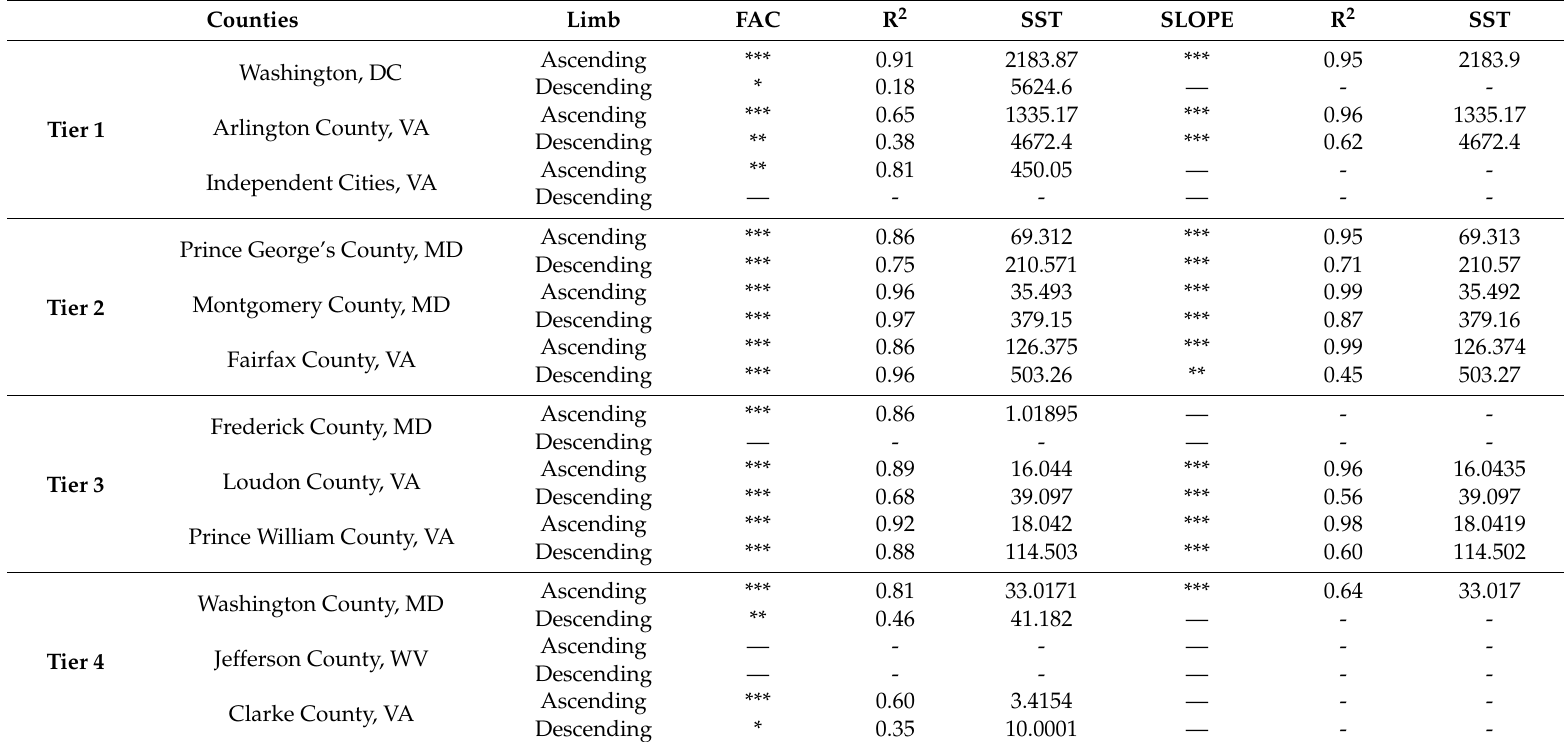
Table 5. Results from linear models consisting of Burial~FAC, and Burial~